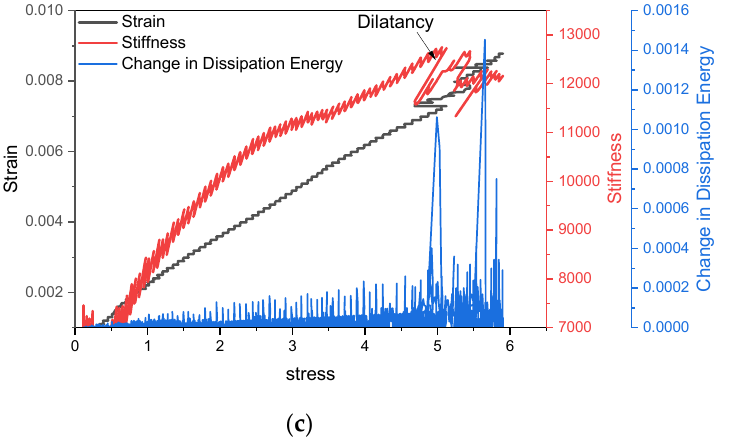
Figure 11. Relation of strain, stiffness, and change in dissipation energy over the stress of ( a ) dry sample, ( b ) natural sample, and ( c ) saturated sample.